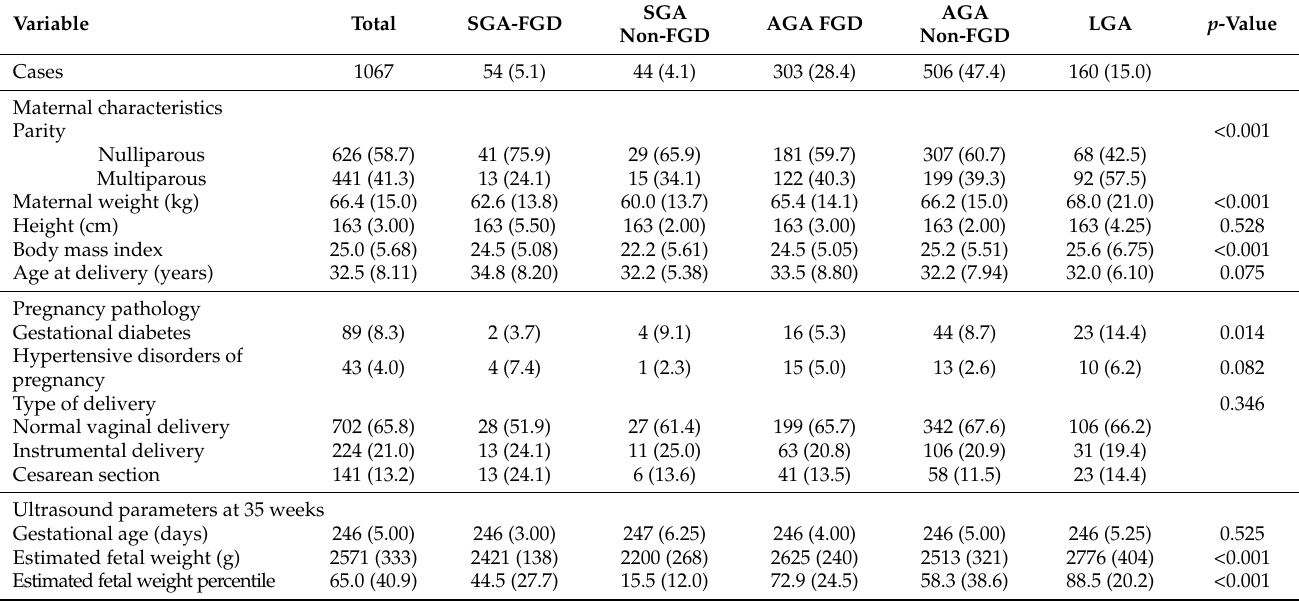
Table 1. Descriptive baseline characteristics. Data are reported as n (%) or median and interquartile range (p25th – p75th).